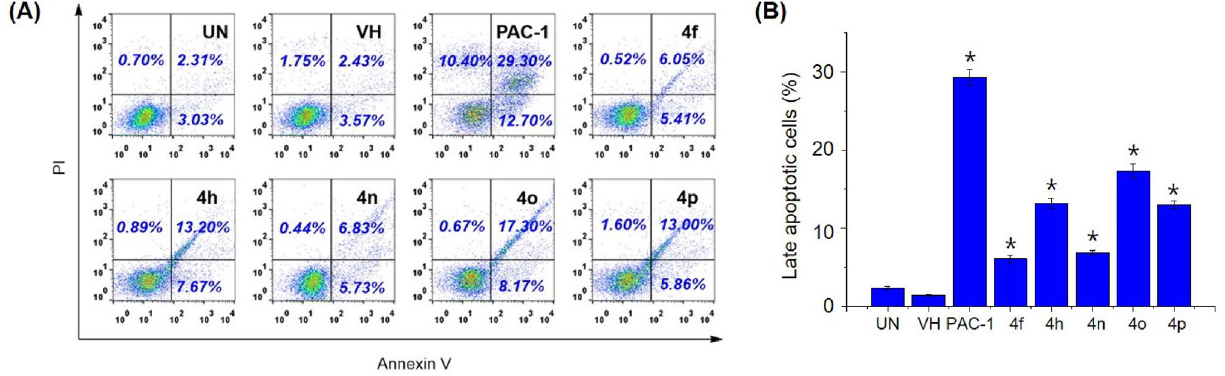
Figure 5. Apoptosis (Annexin V/PI) analysis of cells after treatment with some compounds. U937 cells were treated with compounds (50 µM) for 24 h. The harvested cells were incubated with Annexin V-FITC and PI and analyzed by using flow cytometry. Ten thousand cells were acquired (n = 3). UN untreated, VH vehicle (DMSO. 0.1%). Representative dot plots ( A ). Live cells, left down in dot plot. Early apoptotic cells, right down. Necrotic cells, left up, Late apoptotic cells, right up. Bar graph of late apoptotic cells ( B ). p values were calculated using one-way ANOVA in GraphPad Software (San Diego, CA, USA). * p < 0.01 vs VH control.